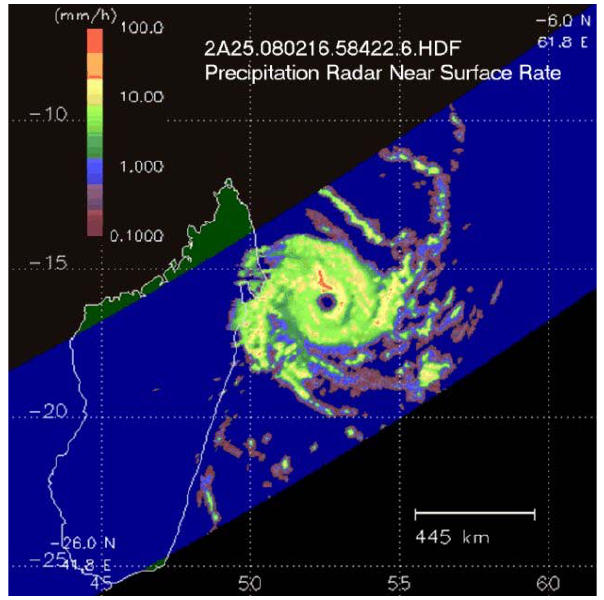
Fig. 15. TRMM precipitation radar near-surface precipitation rate from 06:05:43 to 07:38:06UTC on 16 February 2008.